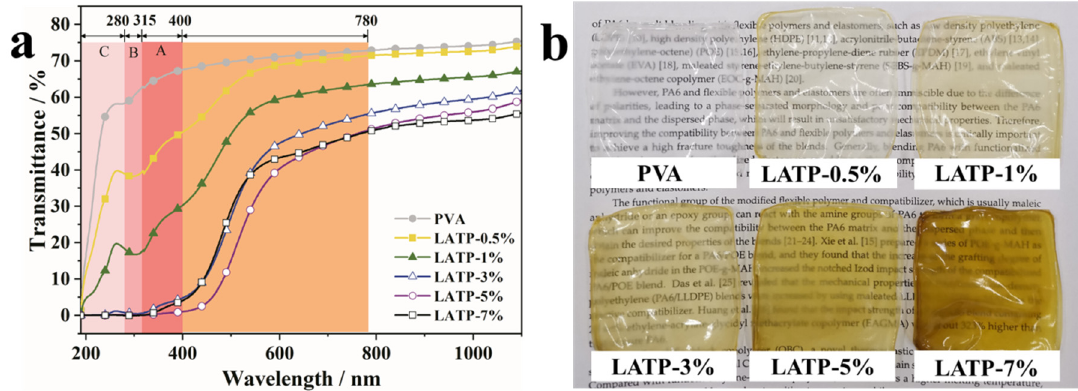
Figure 10. ( a ) UV–Vis light transmittance and ( b ) digital photographs of LDHs@TA-Ti/PVA nanocomposites